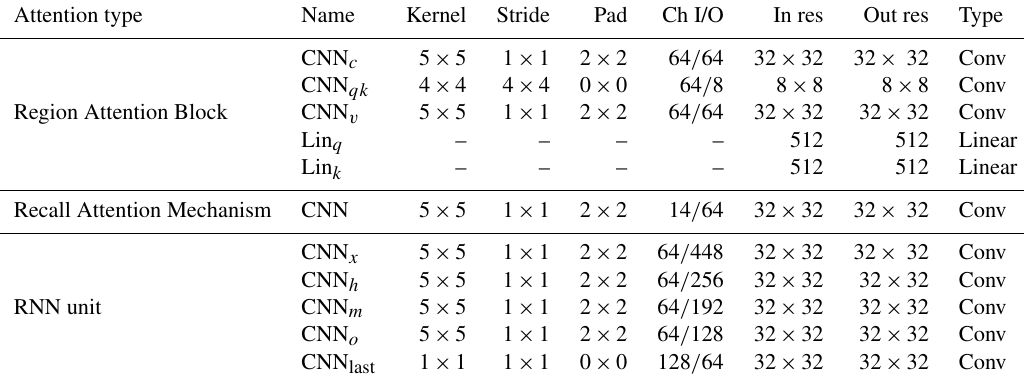
Table 1. The parameter settings of the RAP-Unit. The term “In res” and “Out res” denote the resolutions of input and output, respectively, while “Conv” is the convolution